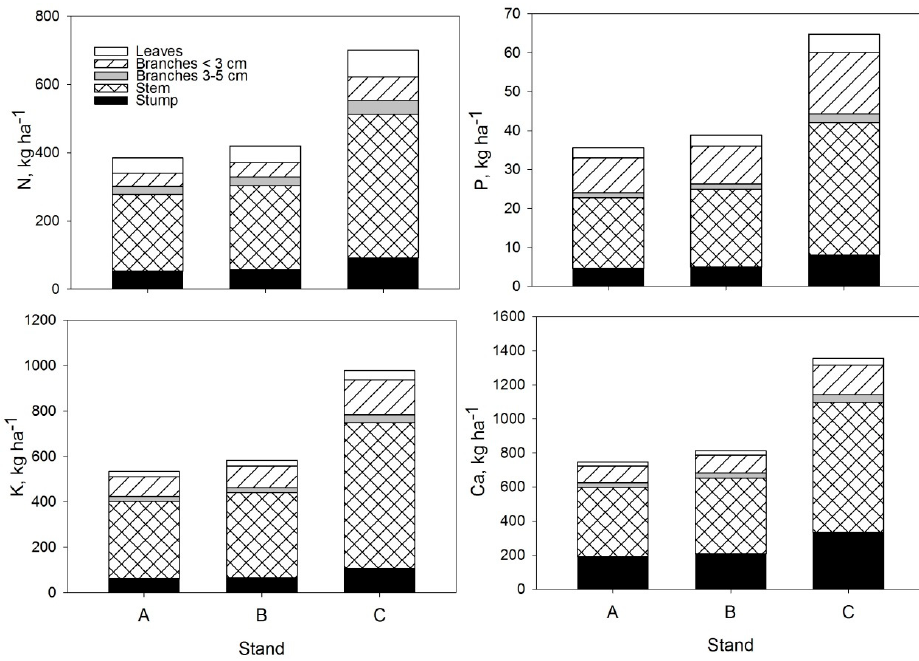
Figure 2. The quantity of N, P, K, and Ca bound in different compartments of rubber tree plantations that were 20 years (Stand A), 25 years (Stand B), and 30 years (Stand C) of age in southern Thailand.